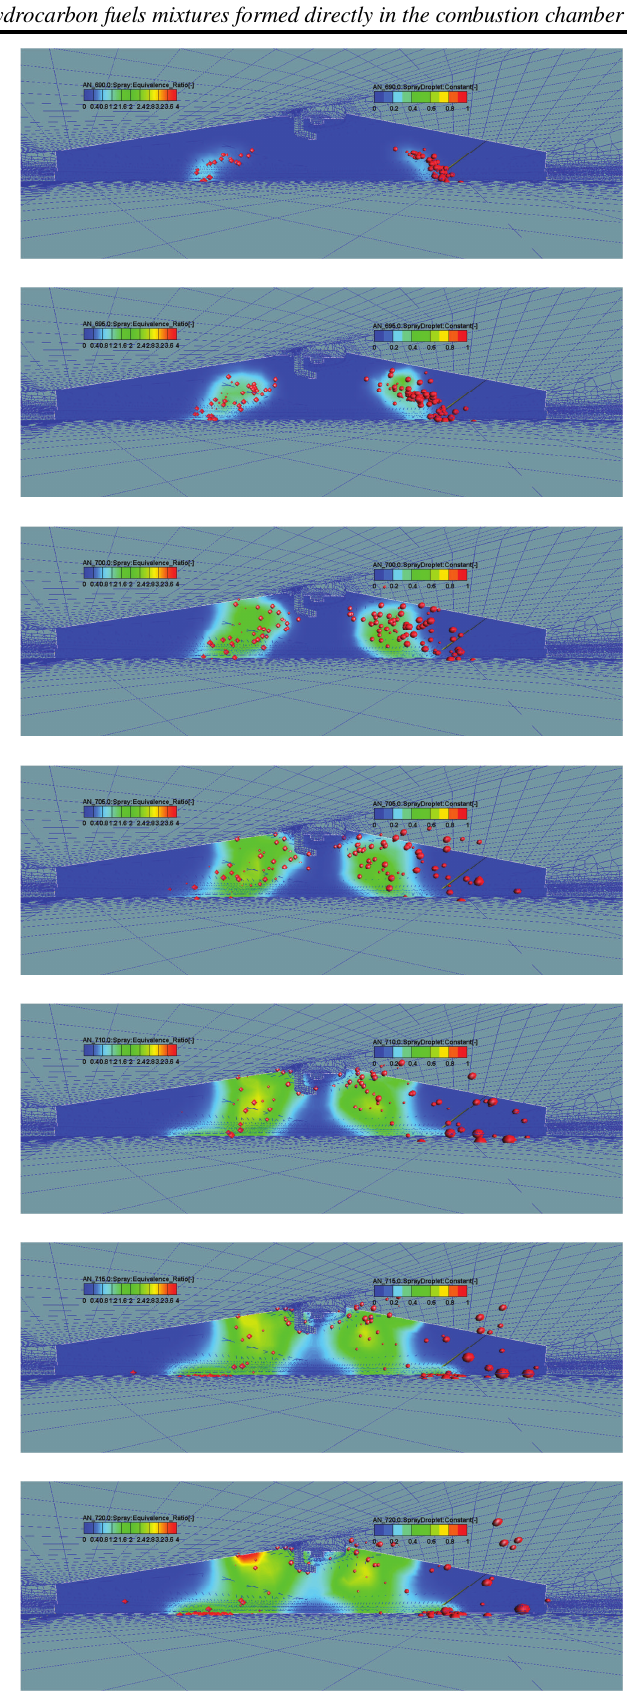
Fig. 7. The development of the gasoline streams in the two-injectors system (combustion chamber section concerns the 1/ l quantity); the droplet color indicates its type of fuel